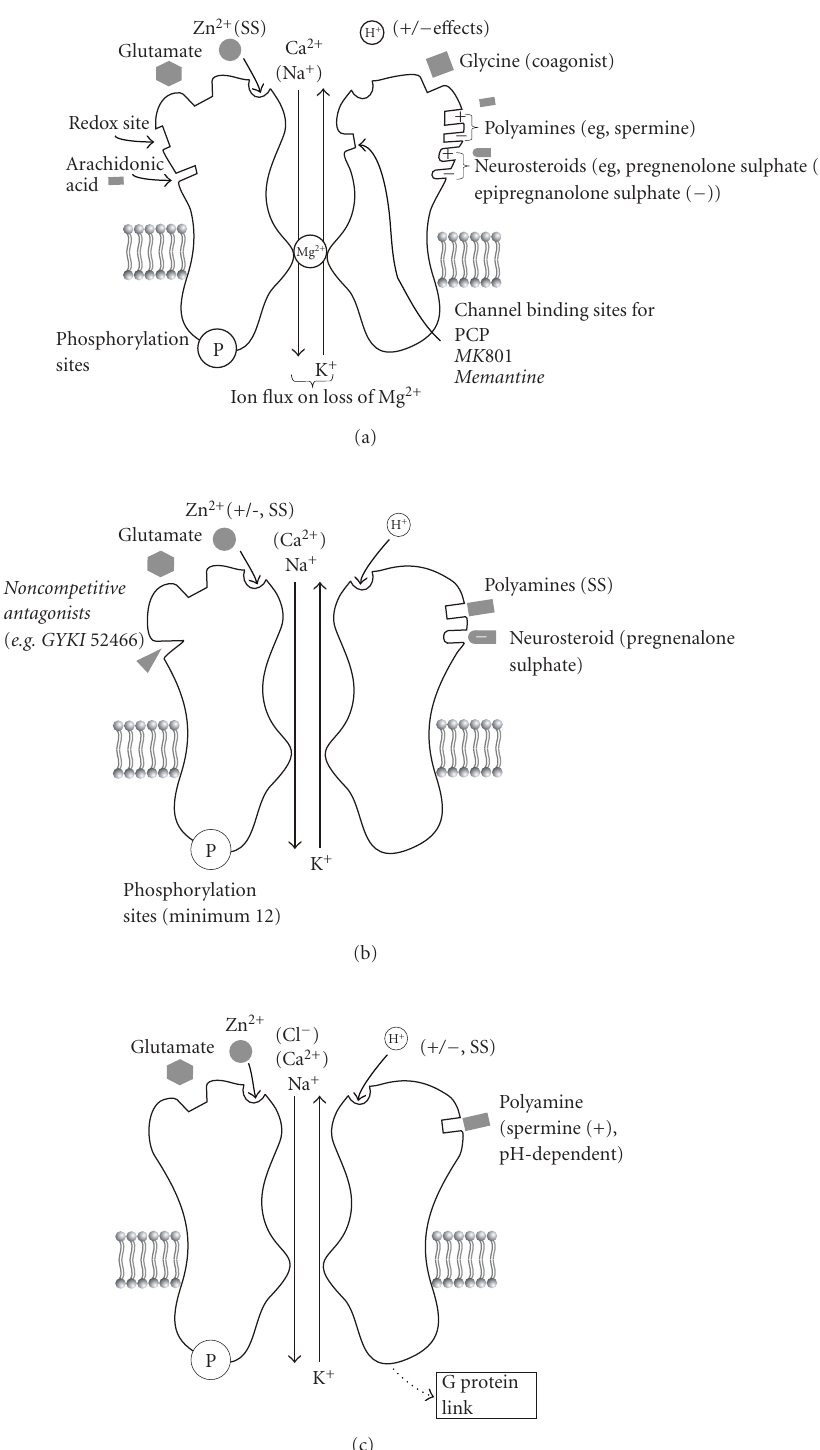
Figure 1: Modulation of ionotropic glutamate receptor function. (a) NMDA receptor, (b) AMPA receptor, and (c) kainate receptor. The main endogenous modulatory sites for the glutamate ionotropic receptors are shown and the sites of key exogenous pharmacological agents are in italics. (+) stimulatory/potentiating action, ( − ) inhibitory action, (SS) subunit-specific action. Additional modifying agents (not shown), where the action has not been specified through a binding site on the receptor, are (a) NO, ethanol, histamine (via polyamine site); (b) arachidonic acid ( − ), NO; (c) ethanol ( − ), arachidonic acid ( − ). The diagram is intended as a summary overview and provides an indication of modulation at these receptors. The discovery of new modulatory agents is ongoing, particularly for the AMPA and kainate receptors, where significantly less is known compared to the NMDA receptor. Abbreviations: H + , proton; NO, nitric oxide; P, phosphorylation site; PCP,